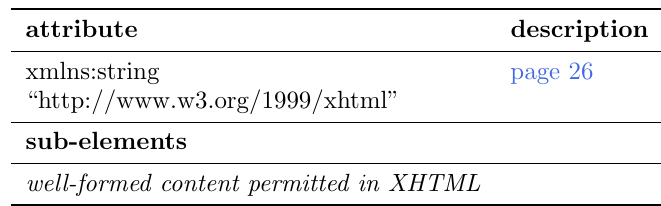
Table 2.1: Attributes and nested elements for Notes. o denotes optional elements and